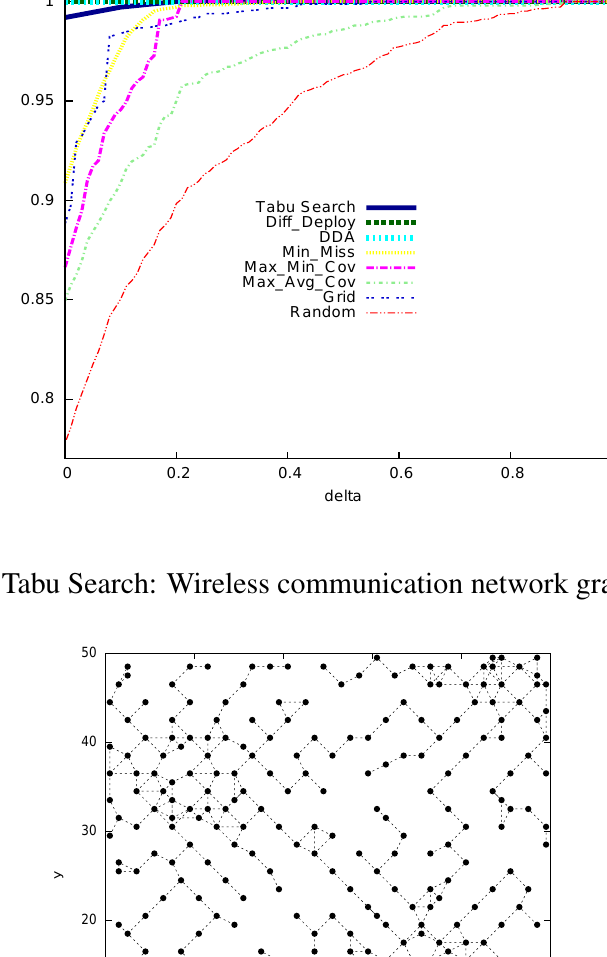
Figure 6. cdf between desired and obtained detection probability considering connectivity